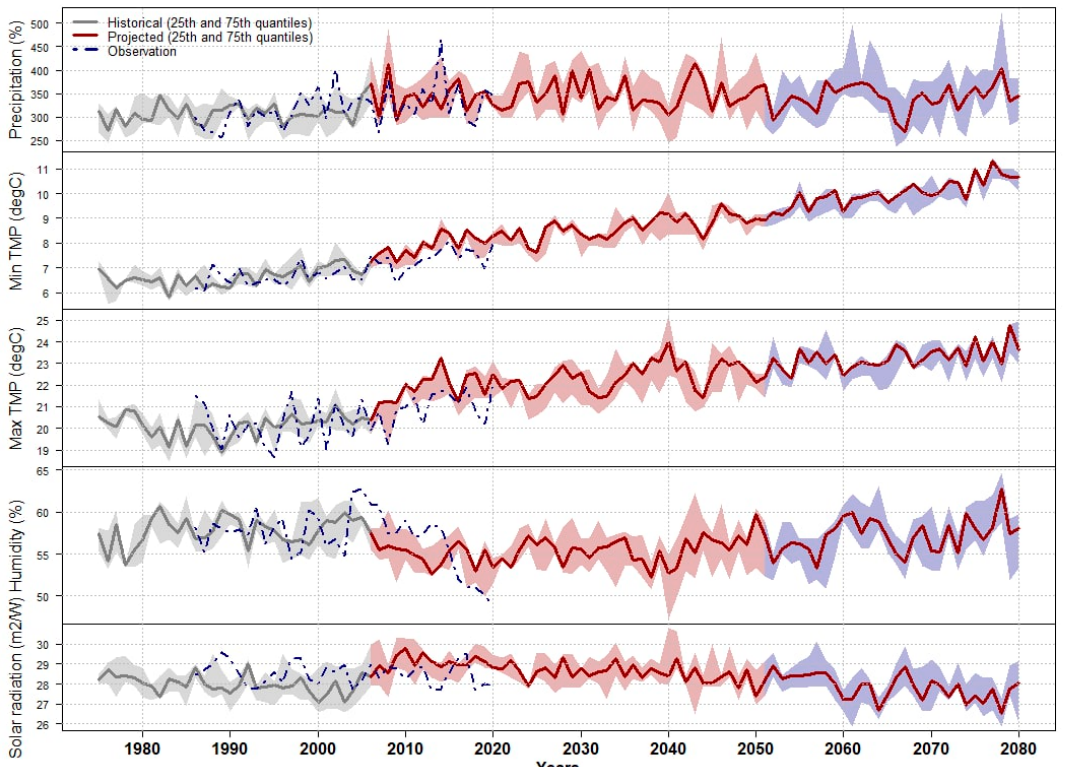
Figure 5. Weather parameters time series for the reference period 1976–2005 mean and RCP8.5 projections from 2005–2080. Solid lines indicate the ensemble medians and the shadings show the interquartile ensemble spread (25th and 75th quantiles).